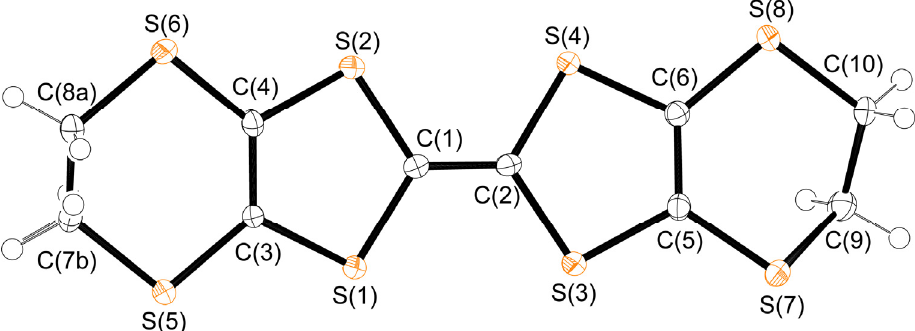
Figure 1. Molecular structure of the donor molecule in 1 with the atom-labeling